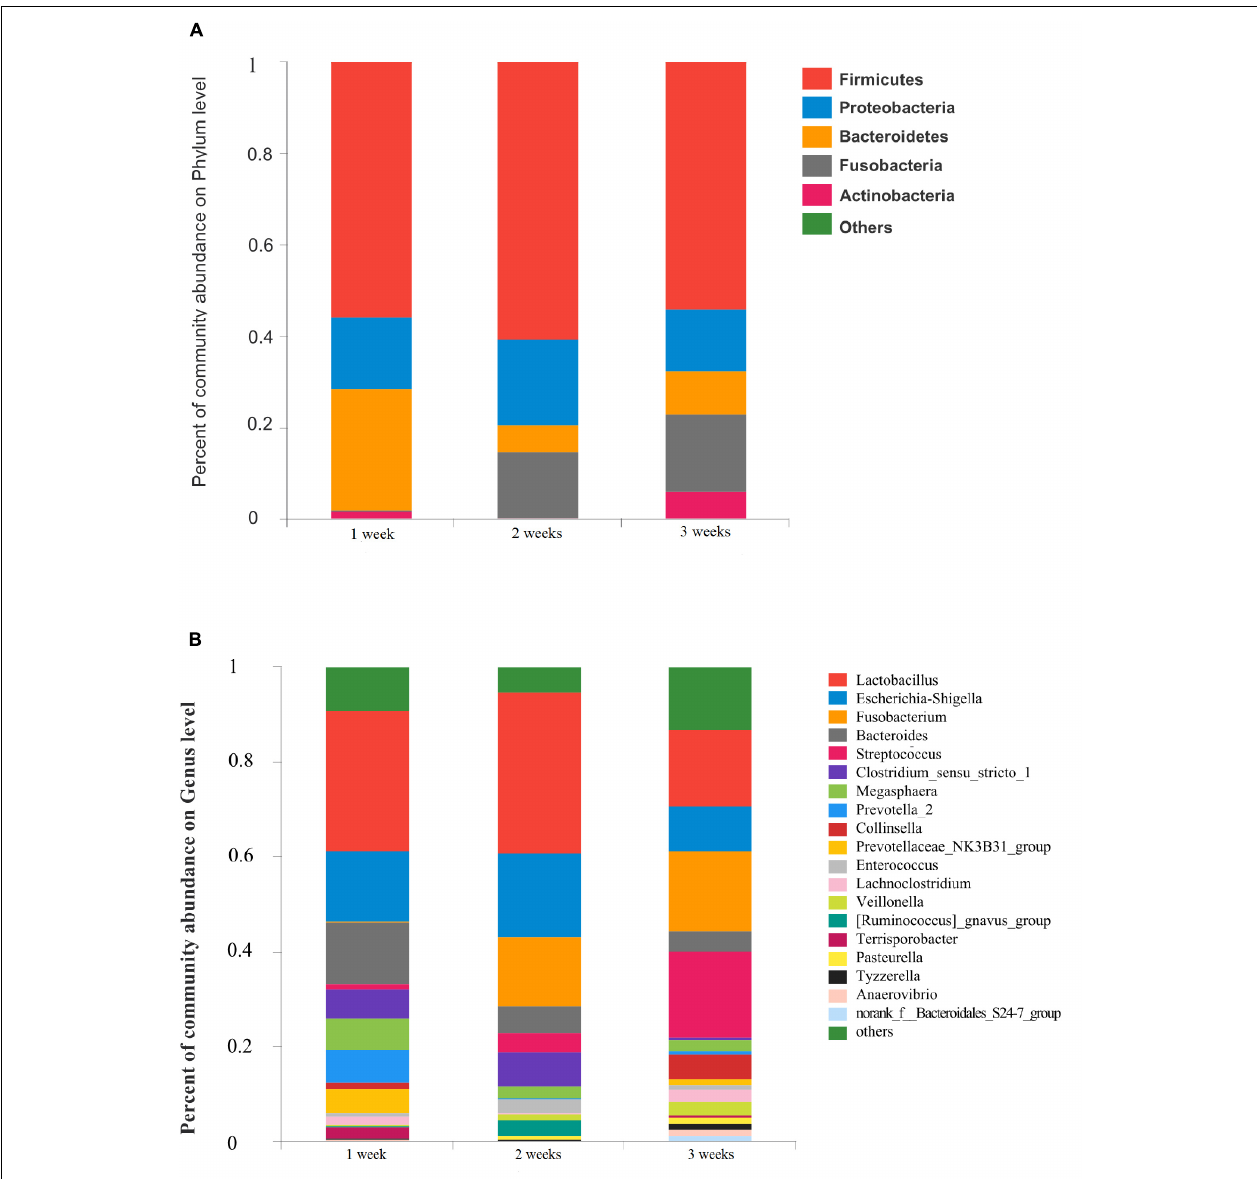
FIGURE 4 | Community bar-plot analysis shows relative abundance of sequences at (A) phylum and (B) genus levels in the three age groups. OTUs comprising less than 1% of the total abundance at both phylum and genus level are represented.